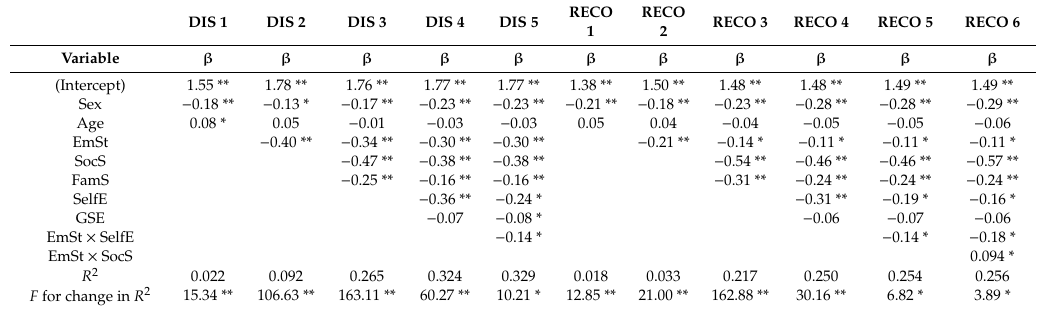
DIS = stress due to occupational discontent, RECO = stress due to a lack of social recognition, EmSt = employment status (reference category: unemployed), SocS = social support, FamS = family support, SelfE = self-esteem,